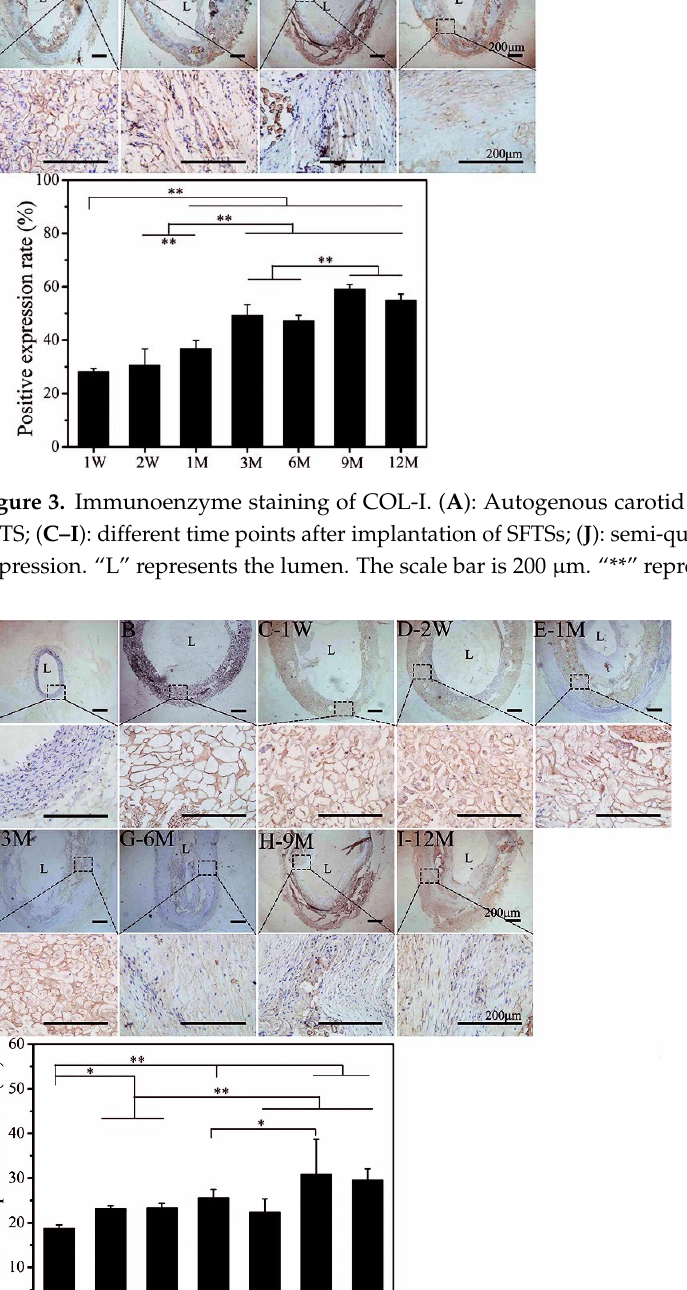
The mRNA expression levels of elastin, COL-I, and COL-III in infiltrated cells in the SFTSs were determined by RT-PCR, as shown in Figure 5. Due to autologous blood ves- sel trauma and contact with foreign materials, SMCs were stimulated to proliferate and secrete ECM at the suture site and were in a secretory phenotype [39]. At the same time, stem cells (such as adipose stem cells [47] and bone marrow mesenchymal stem cells [48]) on both sides migrated into the SFTSs and differentiated into vascular cells, which ex- hibited high proliferation and synthesis of ECM [49]. So, the mRNA expression levels of elastin (1 W) and COL-I (1 M) were up-regulated at the early stage of implantation and then began to decrease but rebounded at 6 M, which was possibly related to the rapid degradation of porous SF at 3 M after implantation (Figure 5A). At 3 M, the pore struc- ture was significantly larger, which was caused by the fracture of the pore wall (Figures 2E and 3E). From 3 M to 9 M after implantation, the mRNA expression level of COL-I showed a similar trend to that of elastin (Figure 5B). The porous SF disappeared and was completely replaced by regenerated ECM at 6 M (Figures 2F and 3F). The environmental changes promoted the transition of SMCs to the contractile type, leading to a significant reduction in extracellular matrix secretion at 9 M (Figure 5A,B). In the first 6 M after im- plantation, the changing trend in COL-III mRNA expression level was similar to that of COL-I. In the early stage of implantation, the mRNA expression level of COL-III was